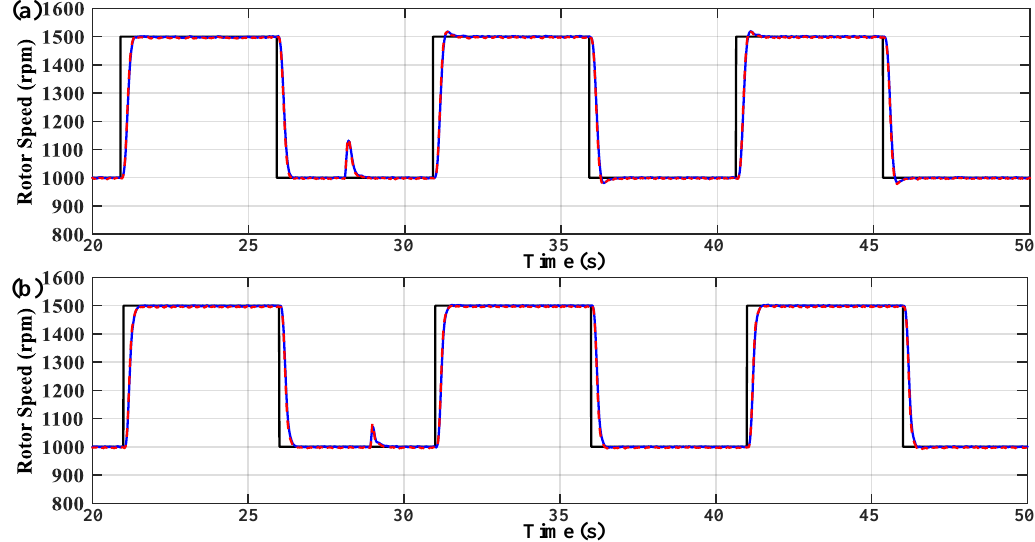
Figure 23. Comparison of speed response of experimental results in the case of the varied external load for R L = 50 → 100 Ω: ( a ) PI controller; and ( b ) NFC controller.